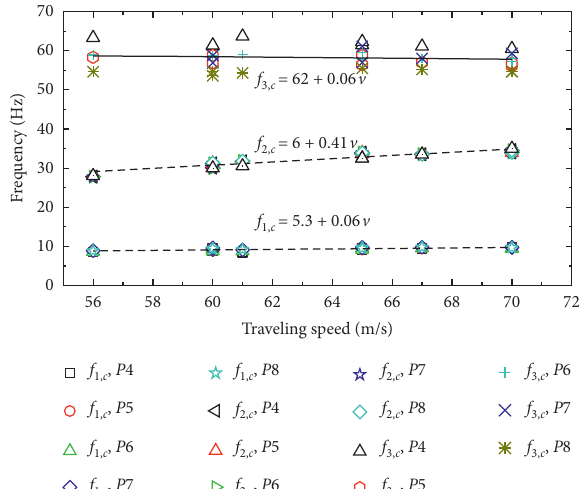
Figure 5: Relationship between traveling speed and fitted dominant frequency.